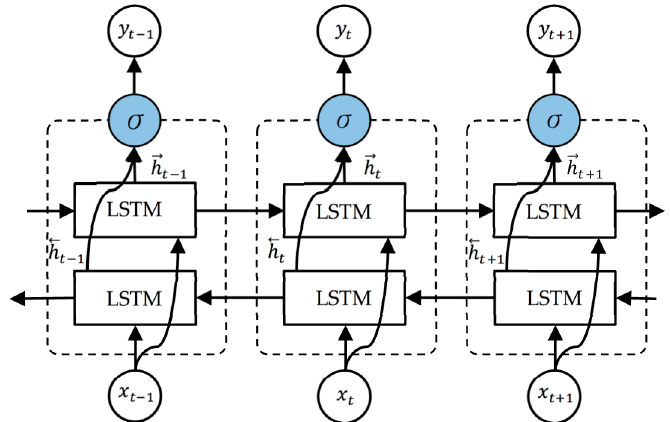
Figure 4. The unfolded architecture of Bidirectional LSTM (BiLSTM) with three consecutive steps.